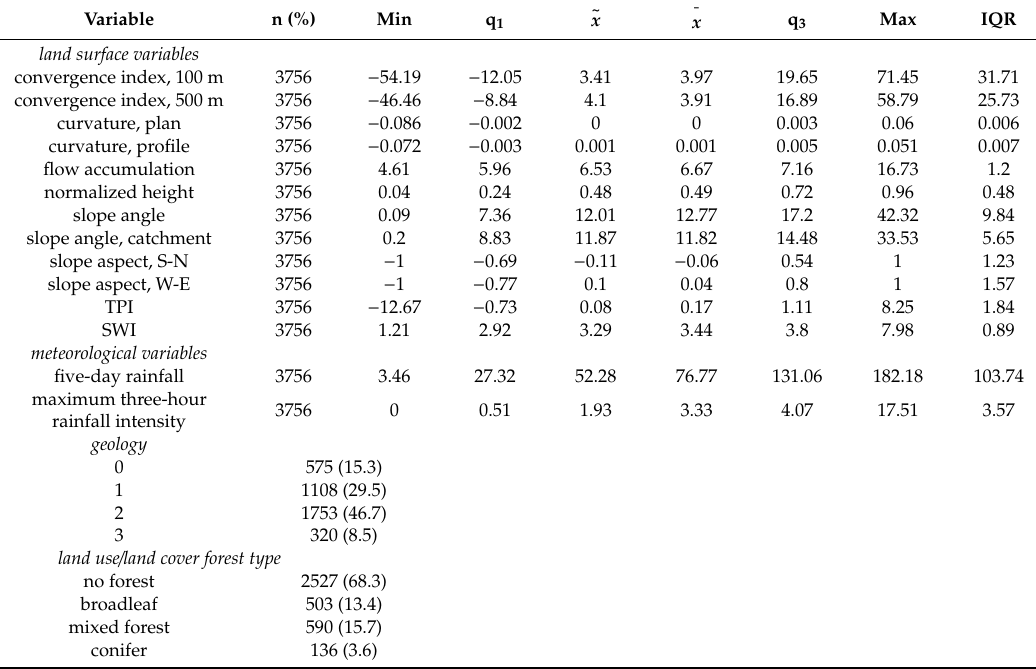
Table A4. Summary of predictor variables for combined-event data.